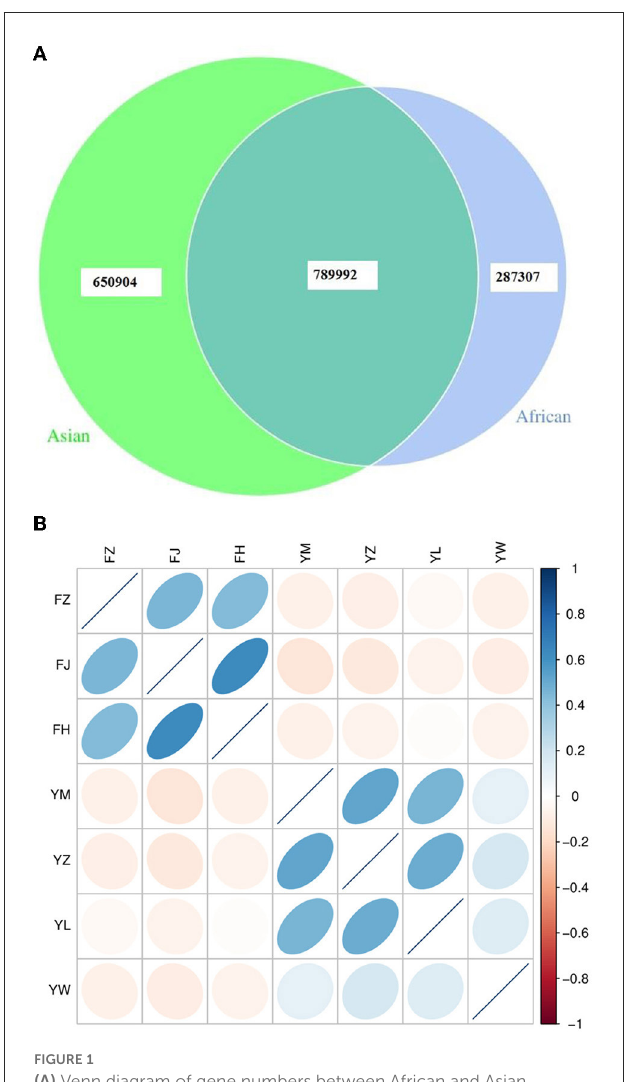
FIGURE1 (A) Venn diagram of gene numbers between African and Asian elephants; (B) Correlation heatmap of gene abundance between samples from African and Asian elephants. The color legend on the right shows the level of correlation coefficient. The ellipse with the darker color means the higher absolute value of the correlation coefficient between samples. The right deviation of the ellipse indicates that the correlation coefficient is positive, and the left deviation is negative. The flatter the ellipse, the greater the absolute value of the correlation coefficient. FZ, FJ, and FH are African elephants. YM, YZ, YL, and YW are Asian